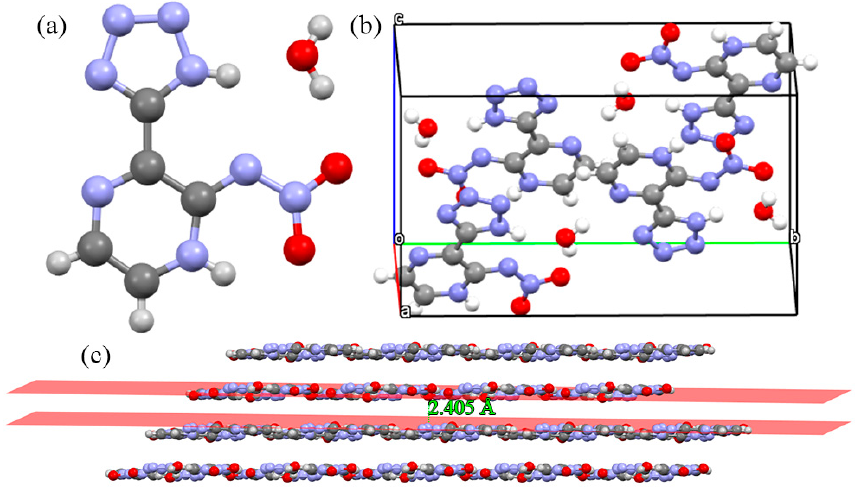
Figure 4. Crystal structures and geometrical configuration of Crystal c : ( a ) crystal structure; ( b ) single unit cell; ( c ) the 3D extended structure.